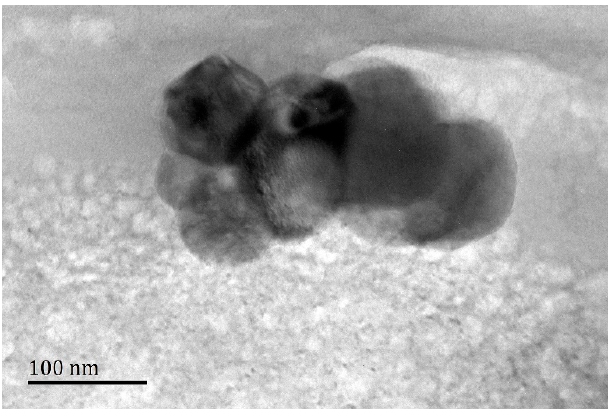
Figure 6. The TEM microstructure of the Al 4 C 3 cluster from several tiny particles.